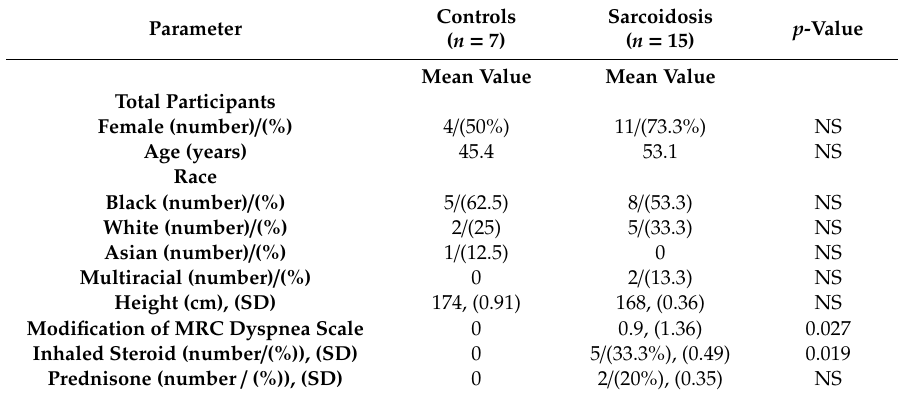
Table 1. Demographics and Basic Clinical Features.